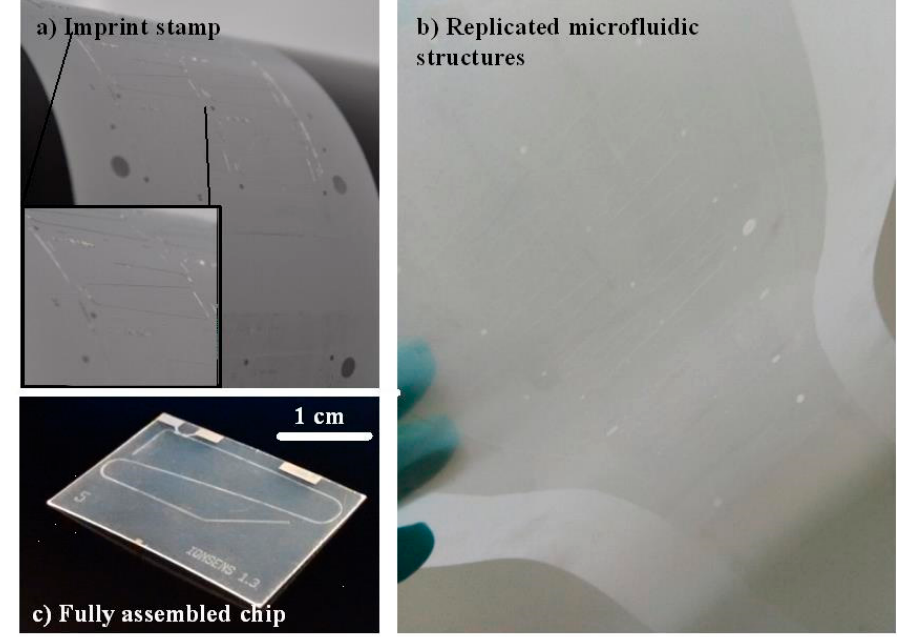
Figure 2. ( a ) The flexible metalized polymer imprint stamp wrapped around an imprint cylinder. ( b ) microfluidic structures replicated in UV NIL Roll-to-Roll process. ( c ) A fully assembled microfluidic CE